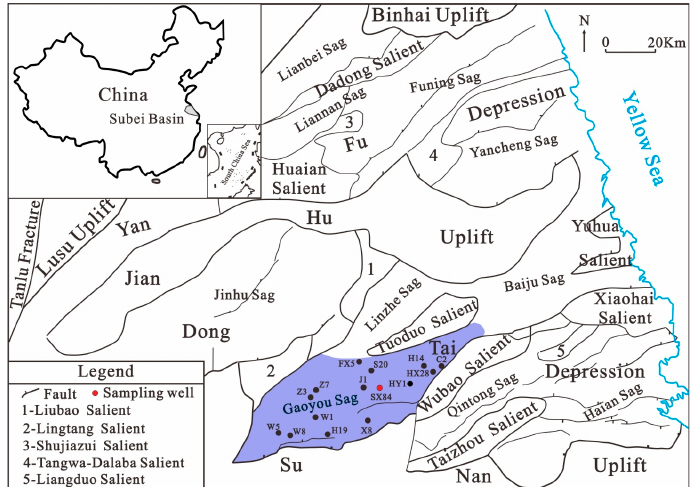
Figure 1. Geological setting of the study area